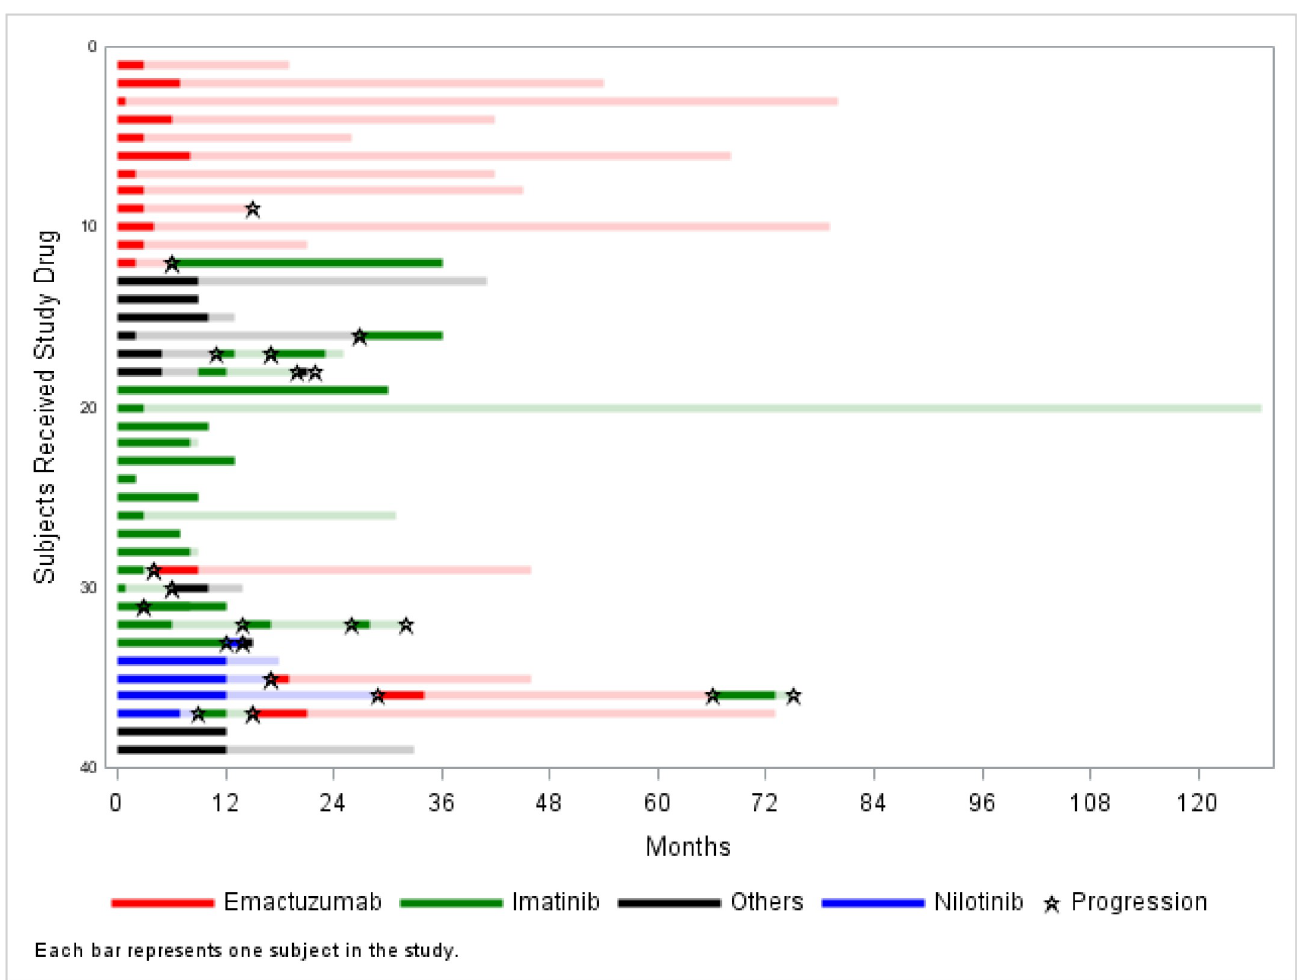
Fig 2. Swimmer plot showing the duration of TKI treatment and TTP for the sequential lines in individual patients.